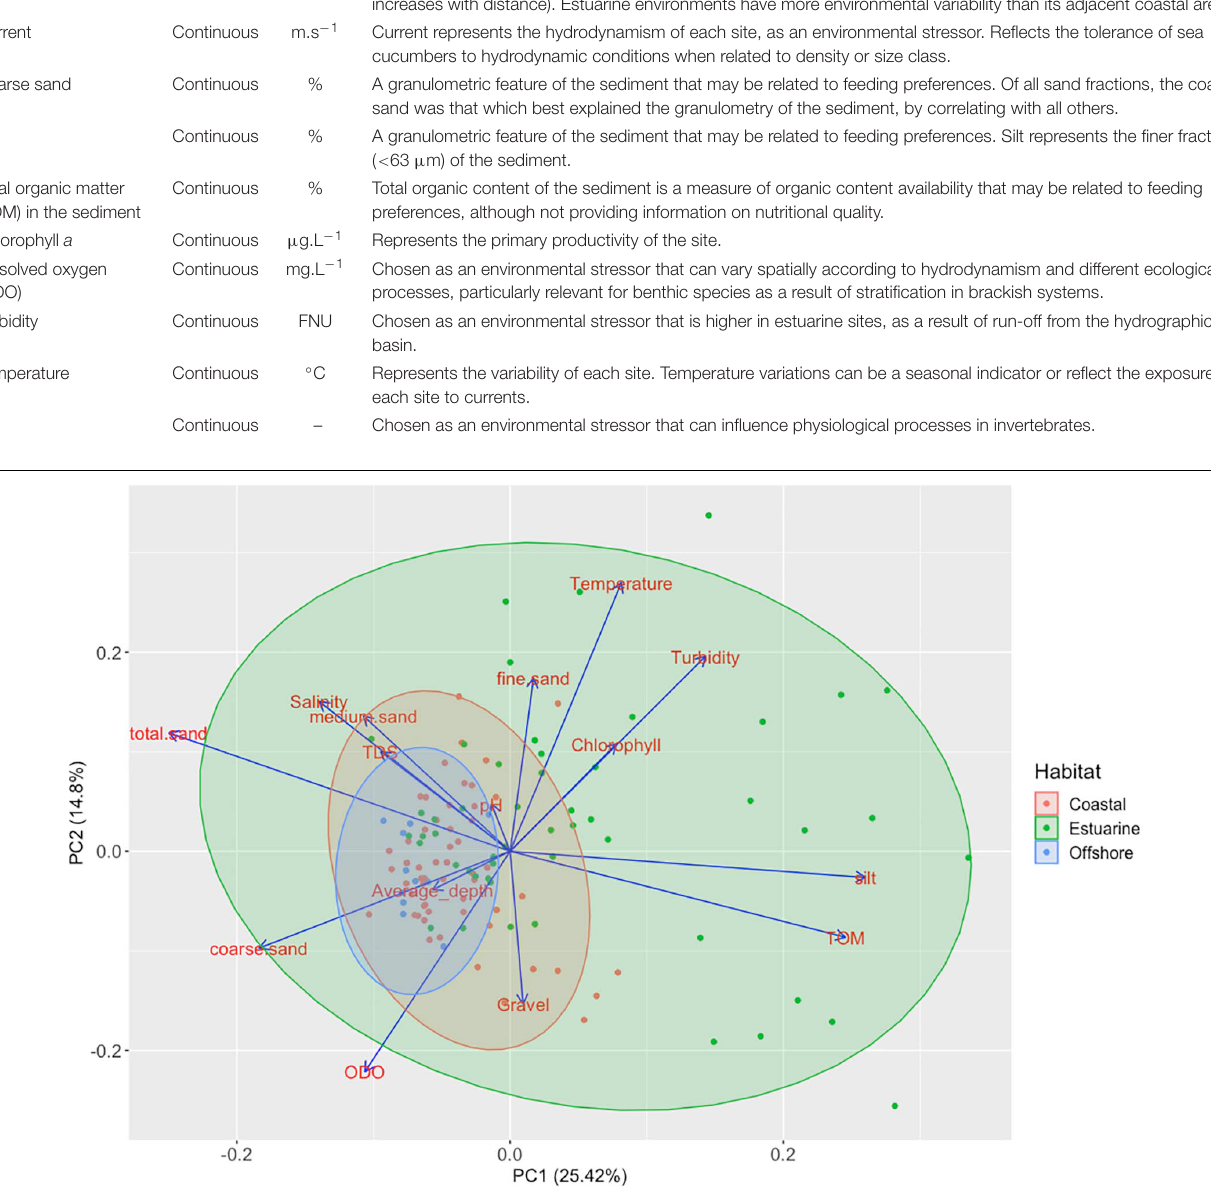
varies according to sampling hour and day (sampling logistics did not allow a standardised sampling regarding the tide). Shelter can find shelter in), a binary variable representing a response